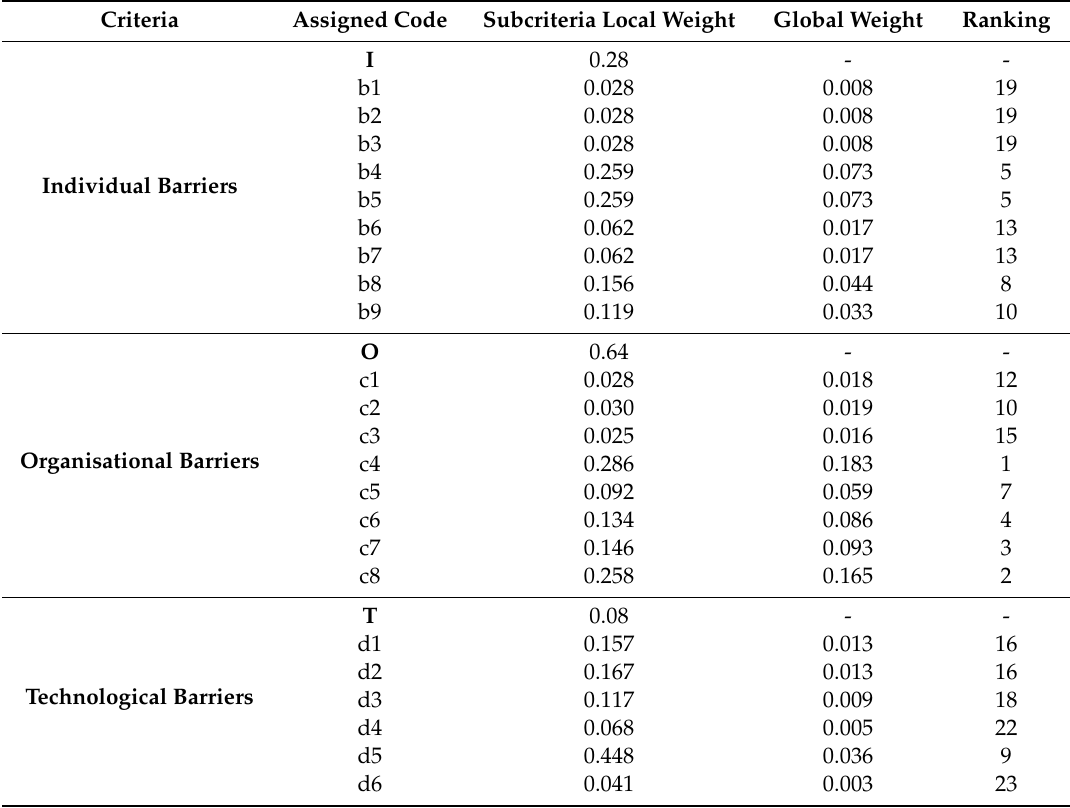
Table 9. Overall priorities ranking of barriers to knowledge management and experience transfer.